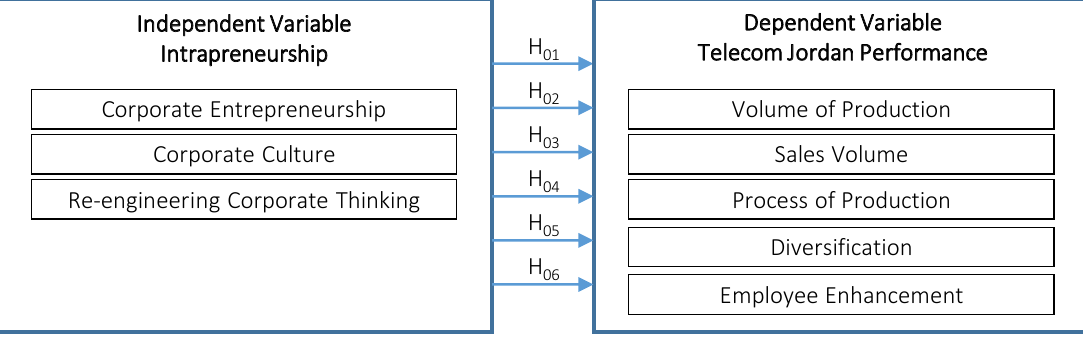
Figure 2. The study model